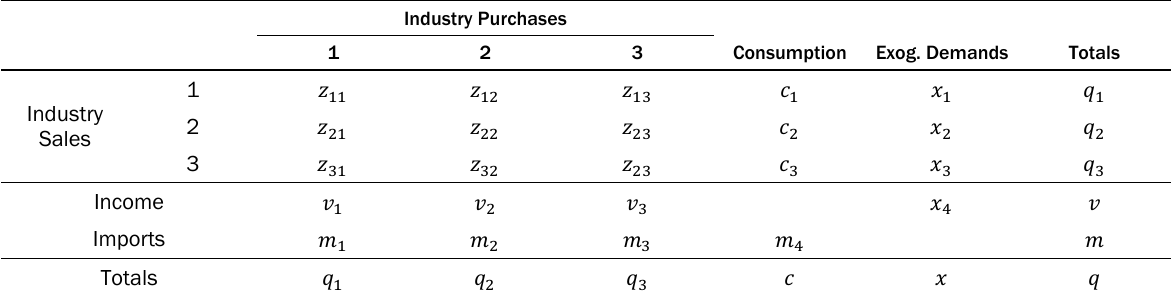
Table A1. Compacted Example of Industry-by-Industry Input-Output Table